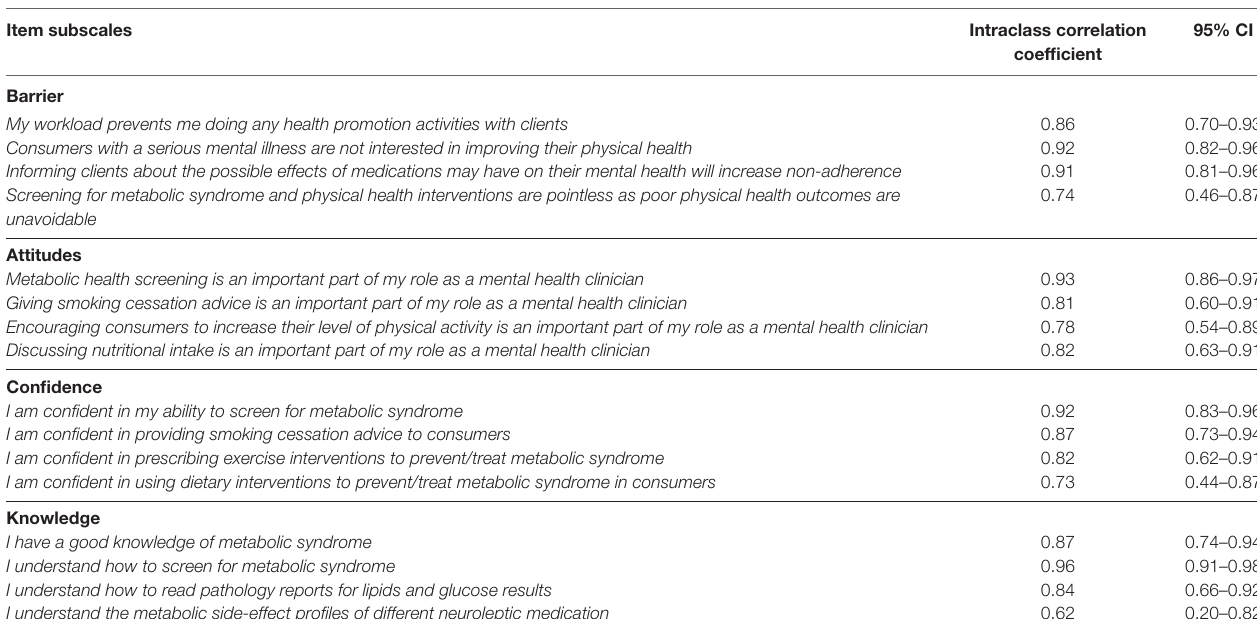
TaBle 1 | Intraclass correlation coefficient